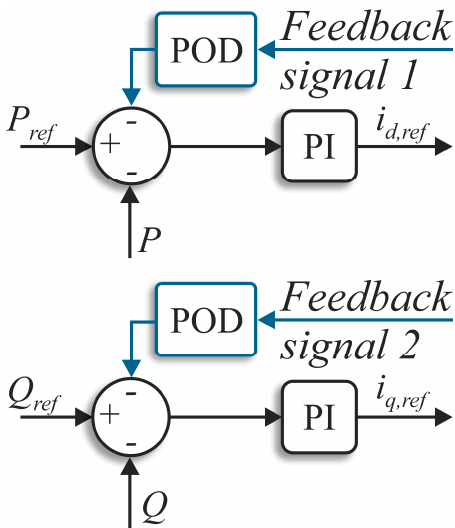
Figure 7. POD modulating the active and/or reactive